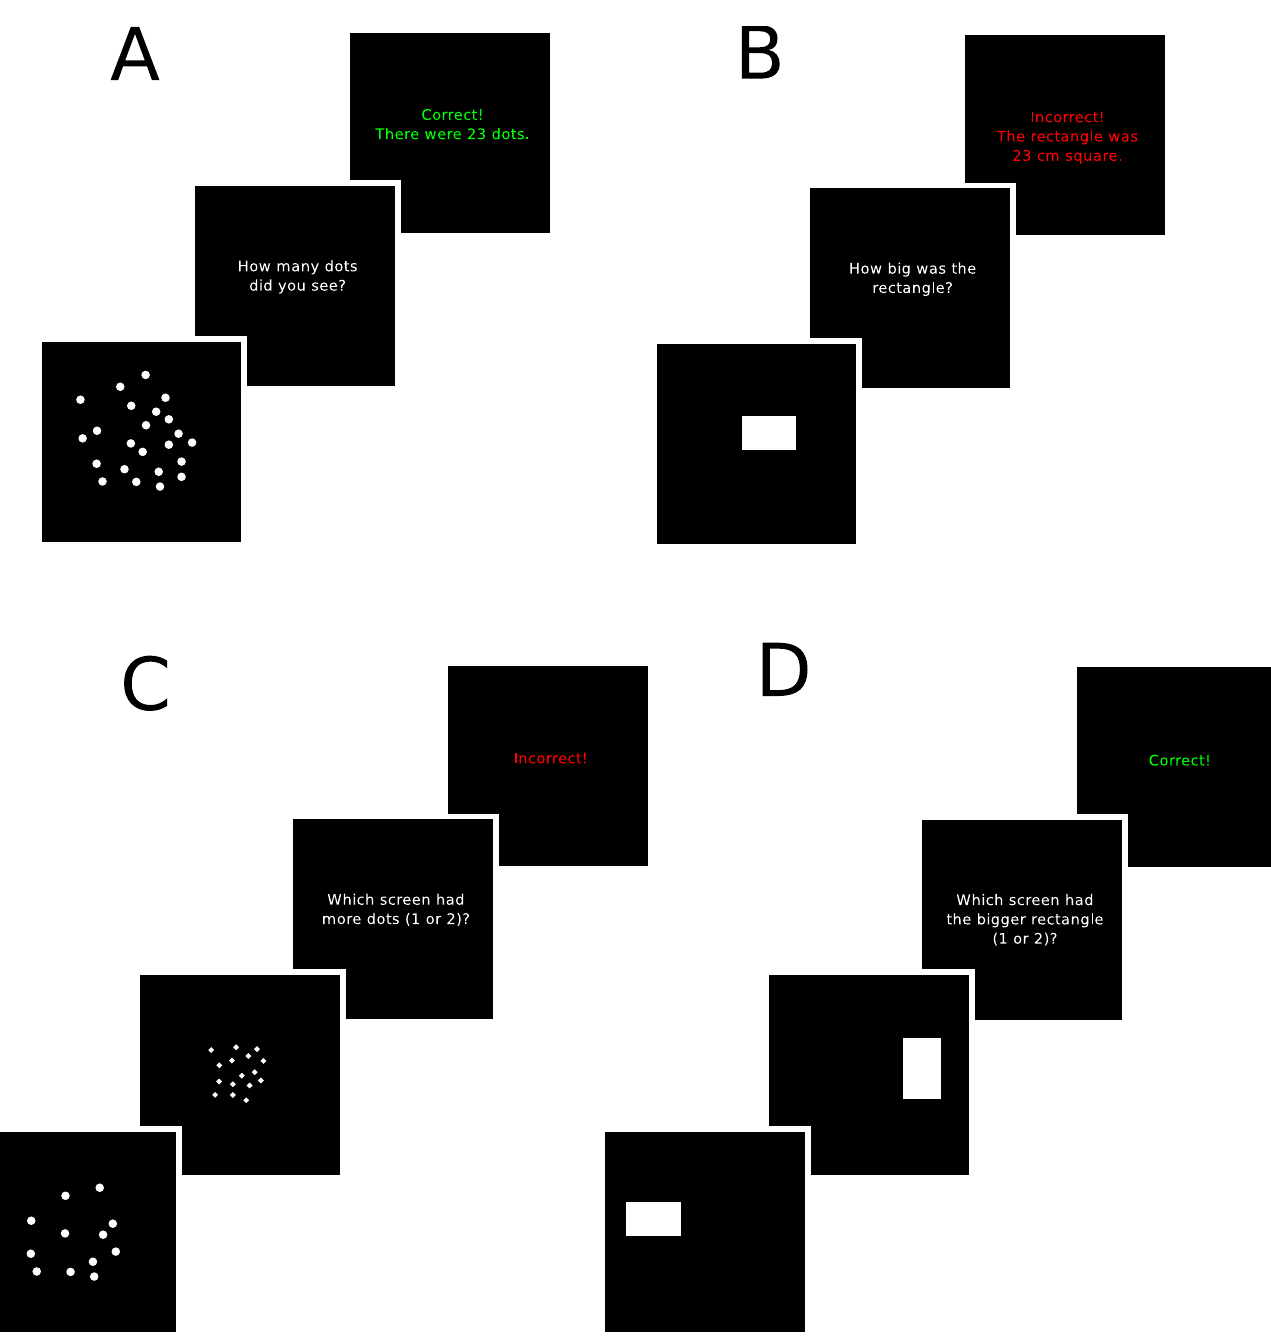
Fig 1. Illustrations of the tasks used in the experiments. A) Estimation trials for dots. B) Estimation trials for rectangle area. C) Discrimination trials for dots. D) Discrimination trials for rectangle